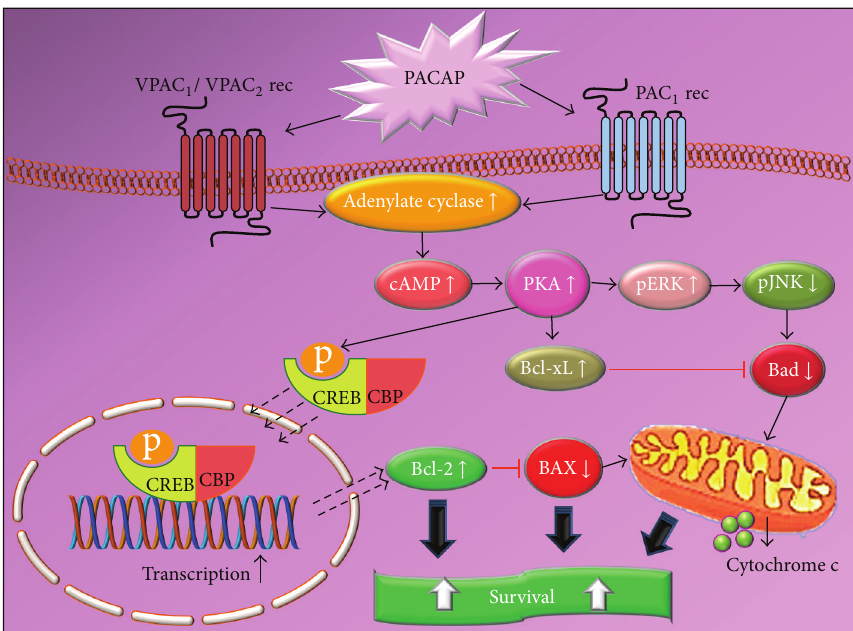
Figure 4: Schematic diagram showing the main prosurvival/antiapoptotic intracellular pathways activated by PACAP. As apparent from the diagram, the intrinsic apoptotic cascade represents one of the main targets of PACAP to protect cells from death. cAMP, cyclic 3 󸀠 ,5 󸀠 adenosine monophosphate; PKA, protein kinase A; PAC 1 , VPAC 1 , VPAC 2 , PACAP-binding receptors; ERK, extracellular regulated protein kinase, Bcl- xL, Bcl-2, antiapoptotic factors; JNK, Janus kinase, Bad, BAX, cytochrome c release, proapoptotic factors; CREB, cAMP responsive element binding protein; CBP, CREB binding